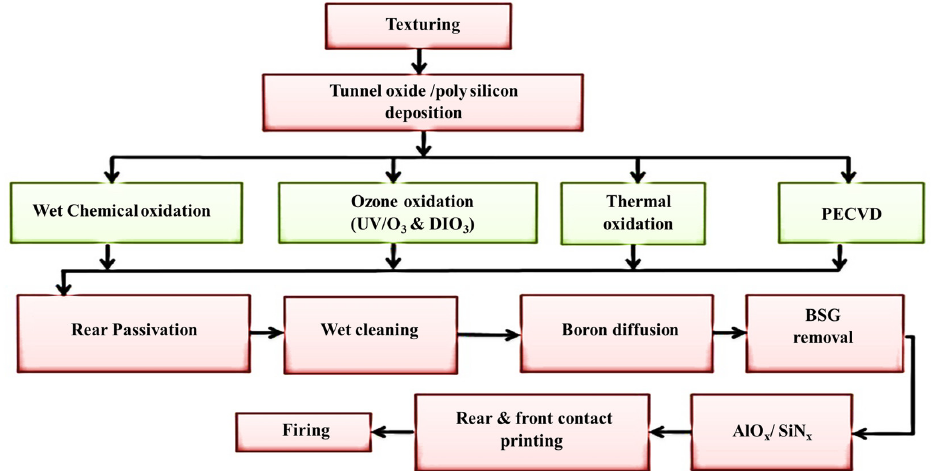
Figure 7. Flowchart of the different techniques used in the manufacture of the TOPCon solar cell. The tunnel oxide deposition techniques are emphasized in green boxes by utilizing TOPCon solar cells.